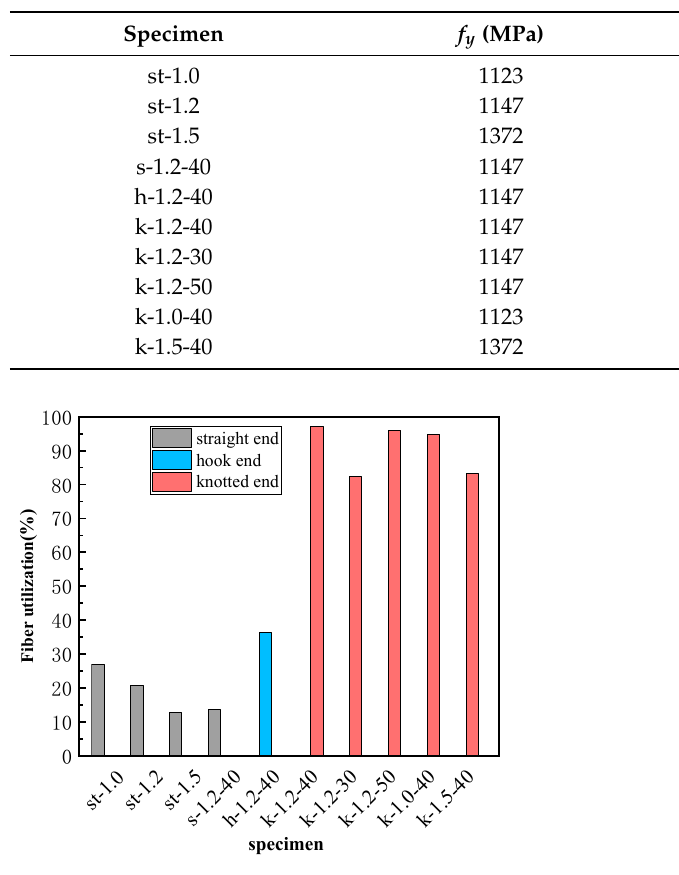
Figure 13. The comparison figure of the SMA strength utilization rate of test specimens. For straight end SMA fibers, the utilization rates are very low, and are less than 30%.